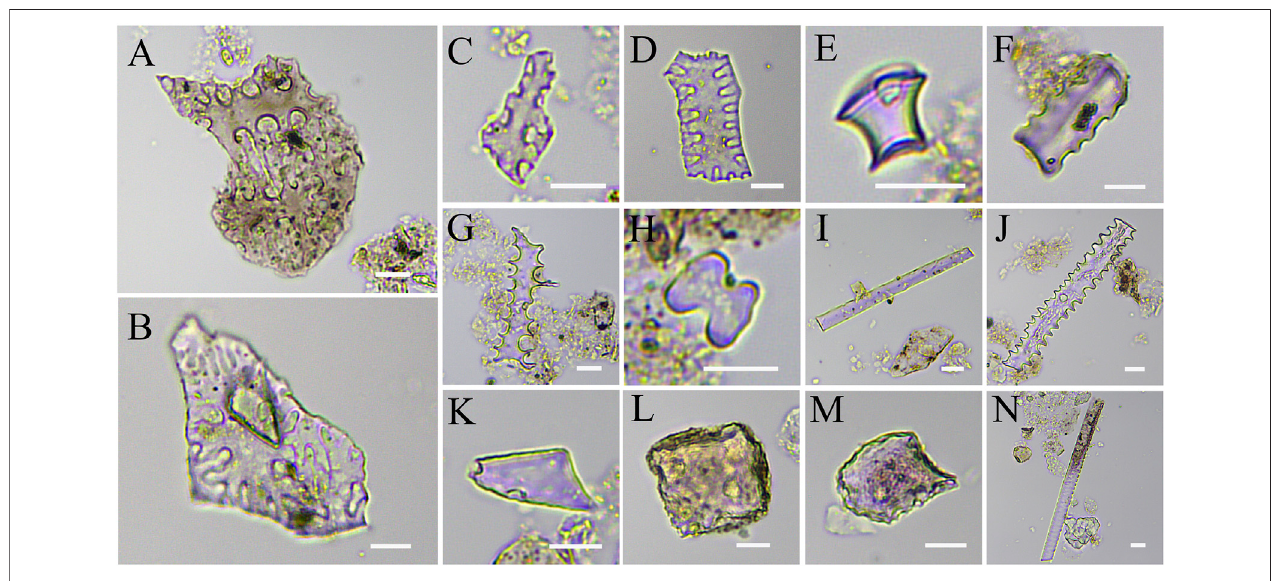
FIGURE 5 | Types of phytoliths extracted from 24 human dental calculus at the Lajia site. (A) – (D) , Epidermal silica layer: (A) INTERDIGITATING Ω -type (B) INTERDIGITATING η -type, (C,D) INTERDIGITATING; (E) RONDEL, (F) CRENATE, (G) ELONGATEDENDRITIC, (H) BILOBATE, (I) ELONGATEENTIRE, (J) ELONGATE DENTATE, (K) ACUTE BULBOSUS, (L) BLOCKY, (M) BULLIFORM FLABELLATE, (N) TRACHEARY (Scale bar: 10 μ m).